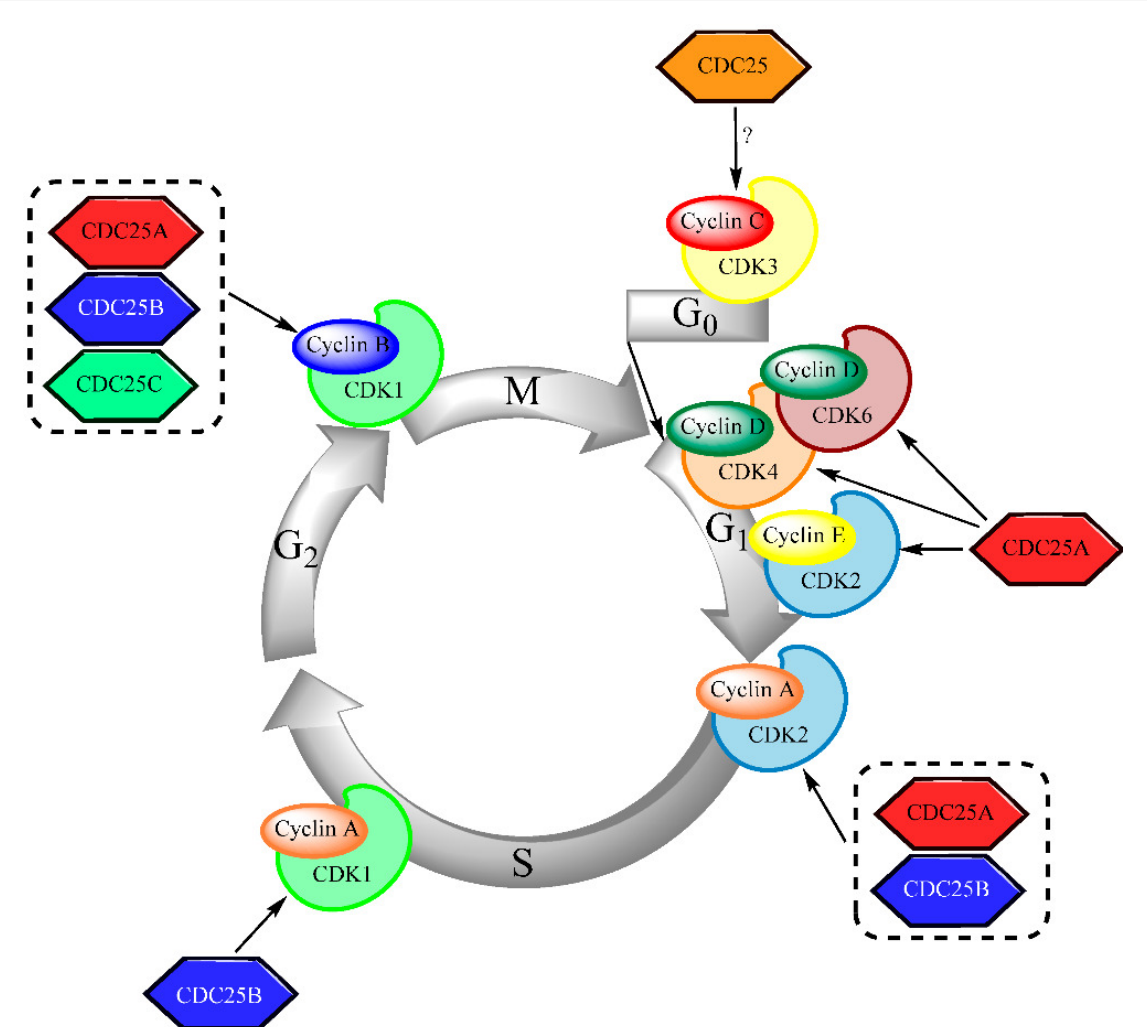
FIGURE 9 - An overview of the regulatory function of CDC25s in the progression of the cycle. M-phase inducer phosphatase 2; Tyrosine protein phosphatase which functions as a dosage-dependent inducer of mitotic progression. Required for G2/M phases of the cell cycle progression and abscission during cytokinesis in a ECT2-dependent manner. Directly dephosphorylates CDK1 and stimulates its kinase activity. The three isoforms seem to have a different level of activity (580